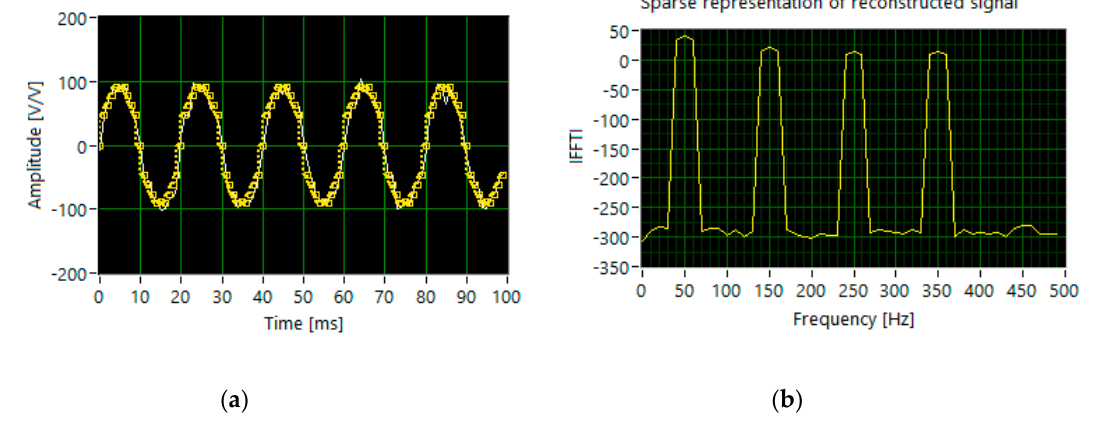
Figure 11. The results of simulation for the input signal (set 3) with the additive noise: ( a ) the segments of time waveforms of the original (white line) and reconstructed signal (dotted yellow line); ( b ) DFT components of the reconstructed signal. The number of measurements is equal to 788.